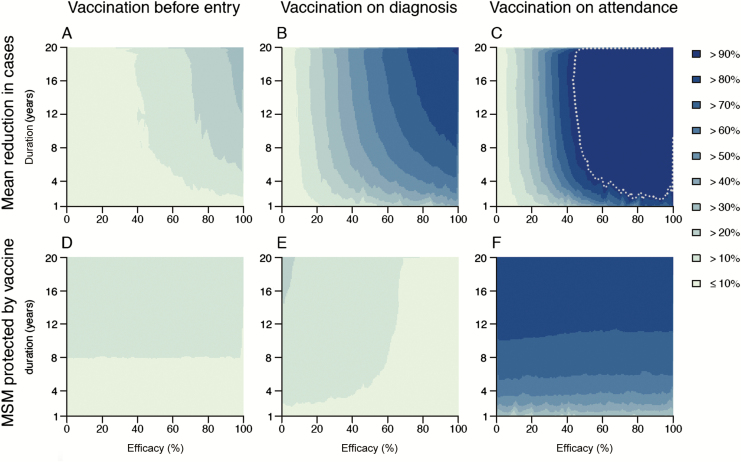
Impact of different vaccination strategies against gonorrhea, given the emergence of a resistant strain in 2020 for which antibiotic treatment always fails. Vaccination was implemented from 2020 and administered to individuals entering the sexually active population (A and D), or to patients diagnosed with gonorrhea (B and E), or to patients on clinic attendance (C and F). Level (horizontal axes) and duration of protection (vertical axes) were varied. A–C, Mean reduction in the expected number of cases in 2030. D–F, Proportion of men who have sex with men protected by the vaccine in 2030. Vaccine profiles (ie, combinations of level and duration of protection) for which the World Health Organization incidence target was achieved by 2030 are highlighted with a dotted line (this is only achieved in part of C). Abbreviation: MSM, men who have sex with men.